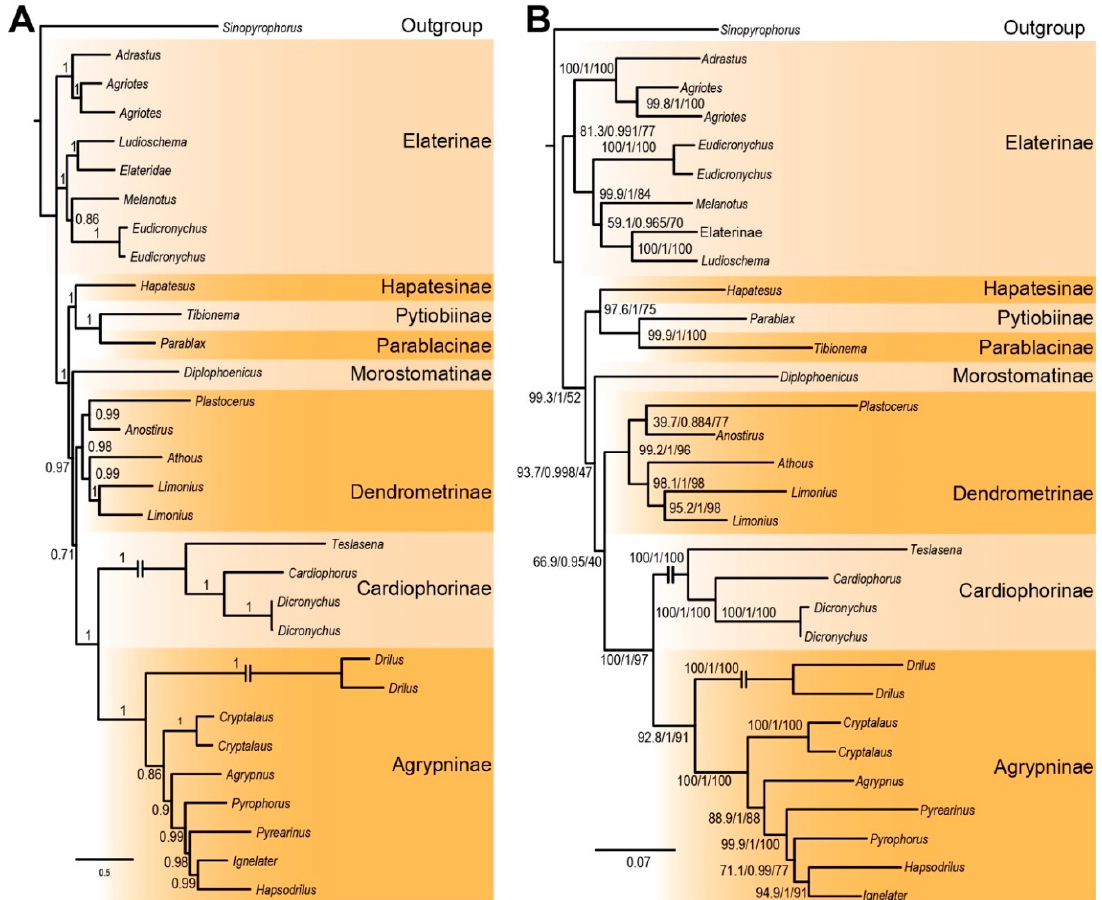
Figure 3. ( A ) Bayesian tree inferred from the unpartitioned dataset NUC123 in PhyloBayes under the site heterogeneous mixture CAT and GTR model. The values at nodes are Bayesian posterior probabilities; ( B ) Maximum likelihood tree from the IQ-TREE analysis of the dataset PCN12. The branch support values represent SH-aLRT, aBayes test, and ultrafast bootstrap. Table 2. Results of likelihood test constrained trees versus an unconstrained tree. DMCA clade—a clade containing Dentrometrinae, Morostomatinae, Cardiophorinae, and Agrypninae; deltaL—logL difference from the maximal logl in the set; bp-RELL—bootstrap proportion using RELL method; p-KH— p -value of one-sided Kishino–Hasegawa);